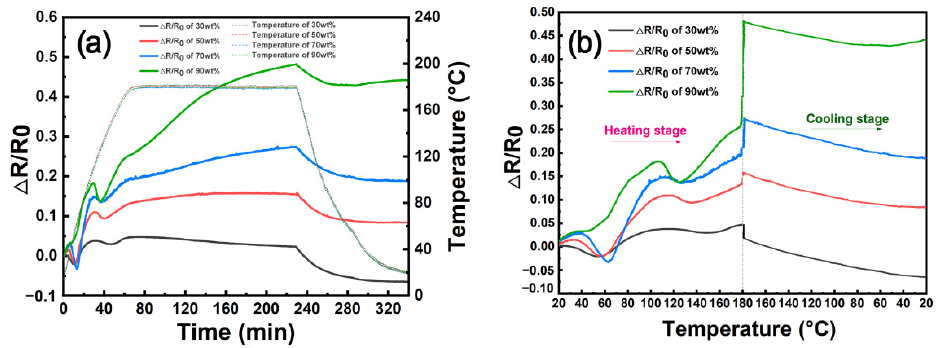
Figure 6. The electrical resistance variation with ( a ) time and ( b ) temperature for CNT/E51-DAD samples with different resin content during curing process.